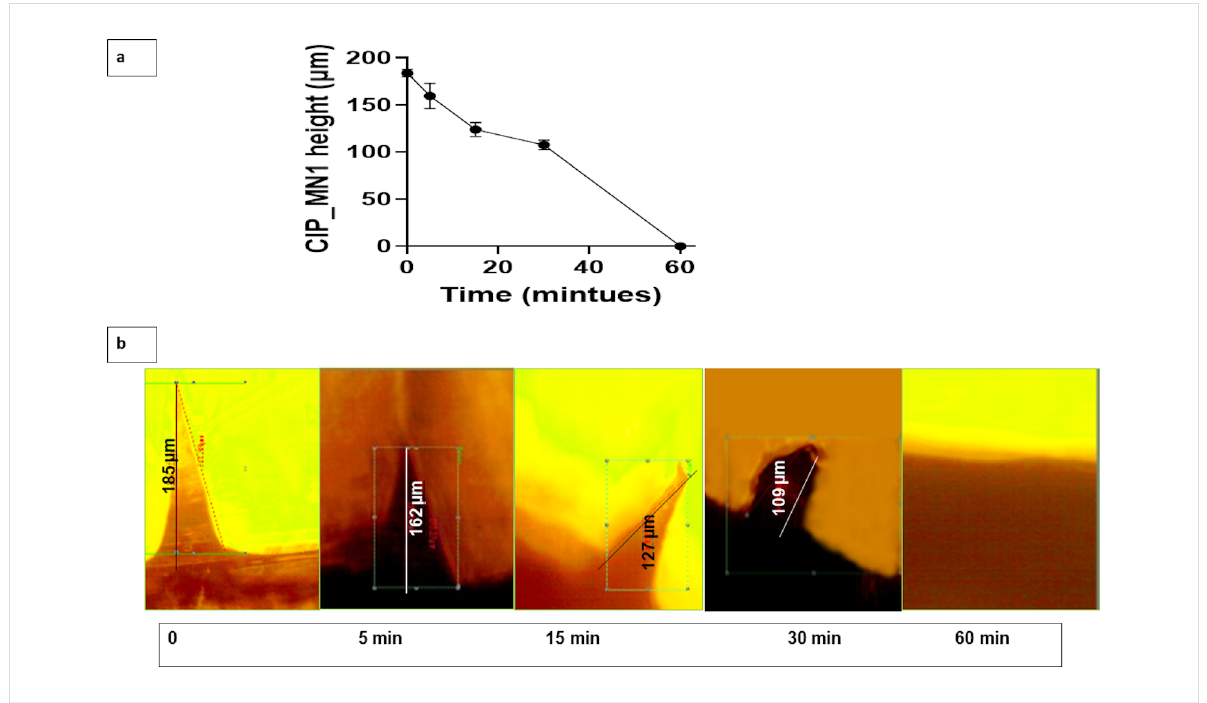
Figure 6: (a) CIP_MN1 dissolution in excised human skin over time (represented by CIP_MN1 height decease with time), n = 3; (b) microscopic image of CIP_MN1 at 0, 5, 15, 30, and 60 min after insertion in excised human skin.